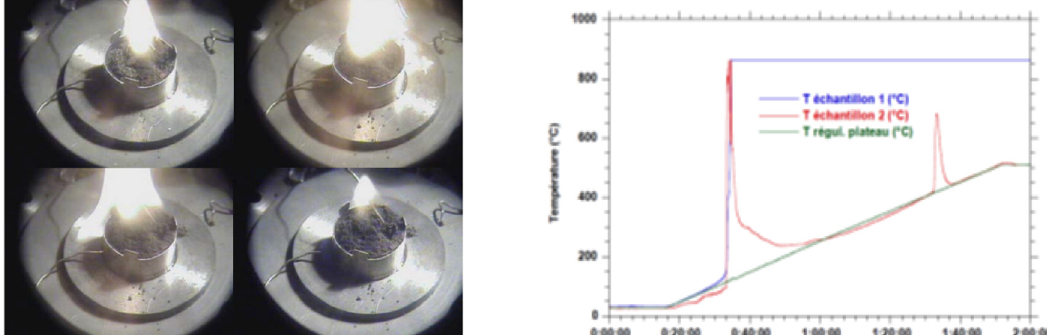
Fig. 2. Ignition near 100 ° C of 6 mm thick UC powder bed (3 grams) (left) pictures during ignition; (right) temperature pro fi le as the base temperature is increased.